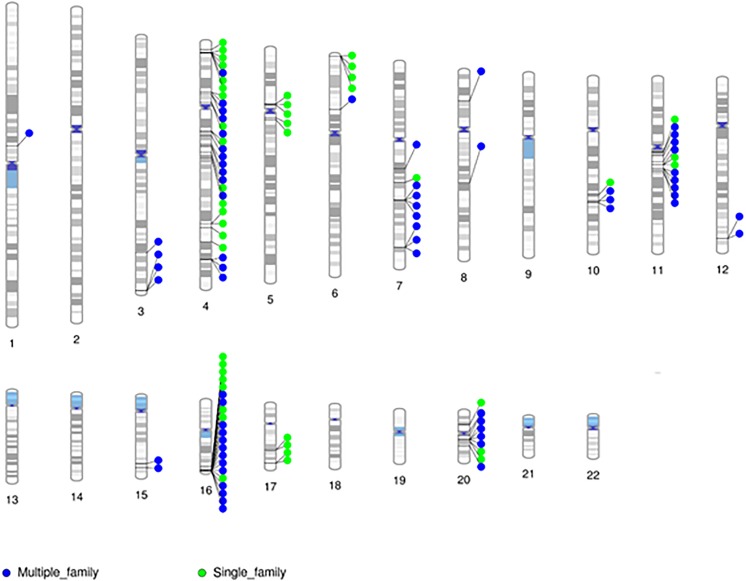
Chromosomal distribution of segregating markers (cumulative LOD ≥ 1.0; n = 110) demonstrates the presence of multiple regions contributing to CVM.